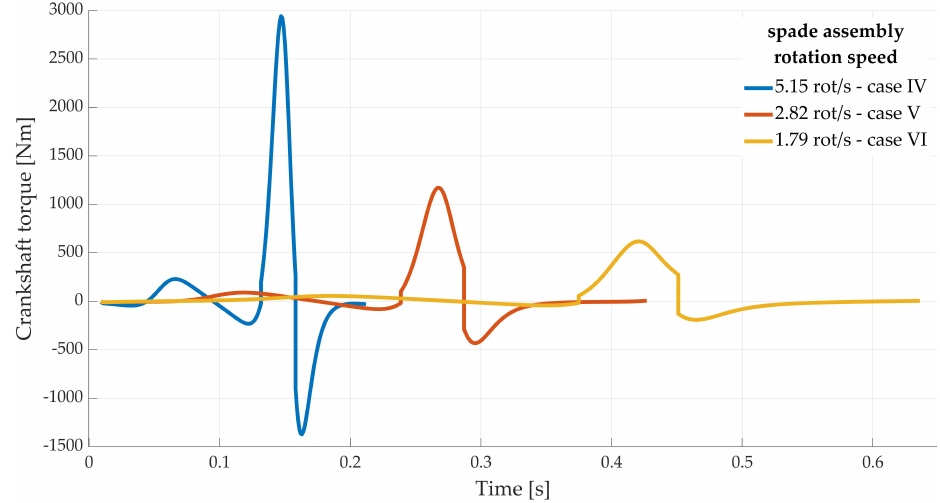
Figure 14. Effect of inertial load on the crankshaft torques using working depth of 0.28 m and machine advancing speed of 0.35 m/s (first cycle presented).